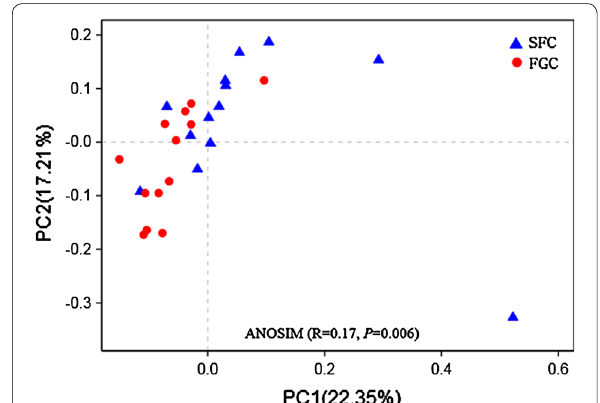
Fig. 2 Principal coordinate analysis (PCoA) of rumen bacterial beta diversity for heifers fed steam flaked corn (SFC) or finely ground corn